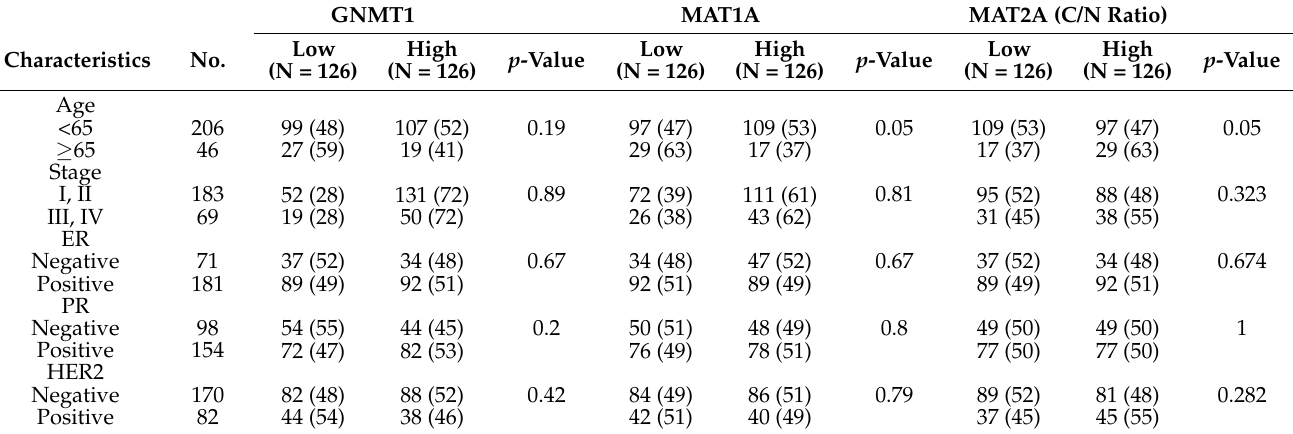
Table 1. Relationships between clinical parameters, GNMT1, MAT1A protein expression, and MAT2A C/N ratio in 252 breast cancer patients. GNMT1 MAT1A MAT2A (C/N Ratio) Characteristics